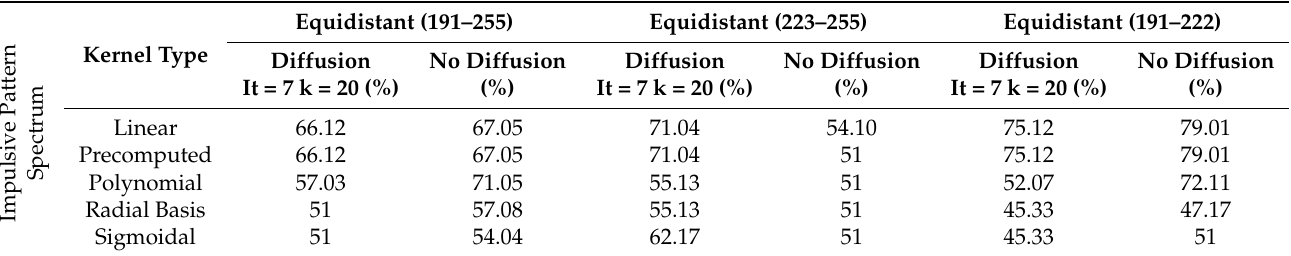
Table 2. Drunk person identification results for the three isothermal regions and feature vector the impulse pattern spectrum for various kernel types. The best performance is obtained for isotherms (191–222) both with or without diffusion.